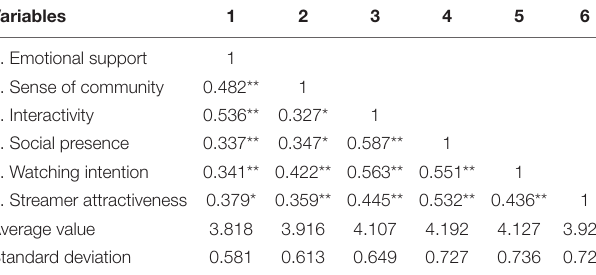
TABLE 4 | Correlation matrix of latent